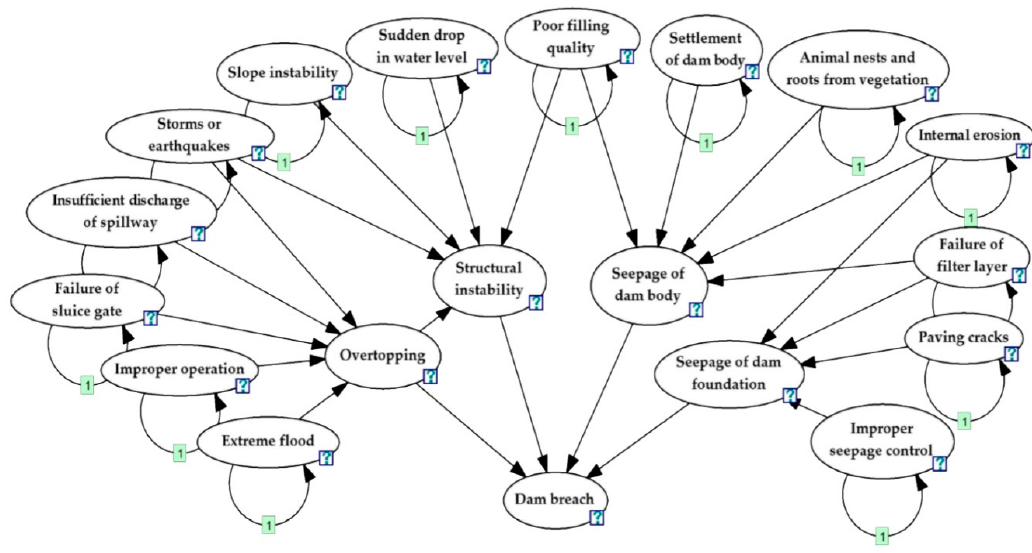
Figure 5. DBN model of the earth-rock dam breach.